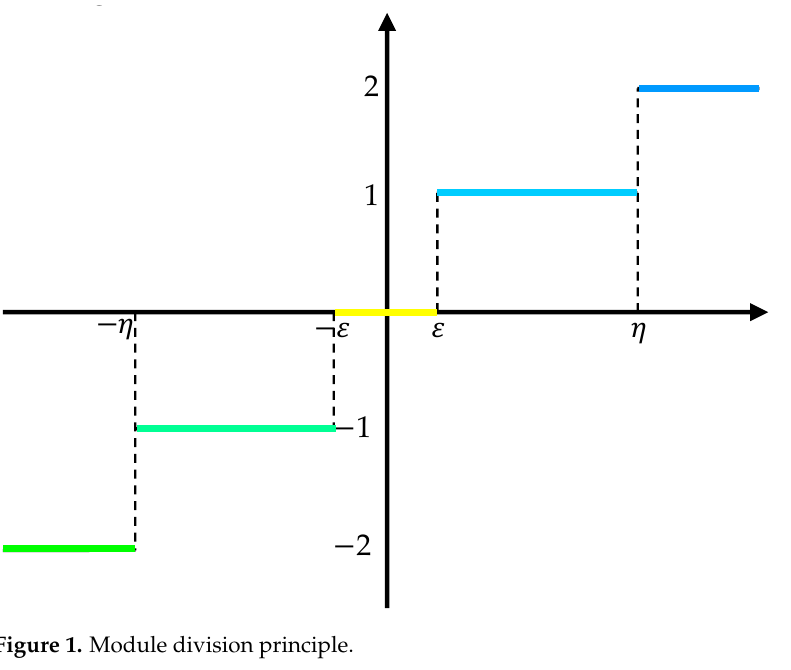
Figure 1. Module division principle.